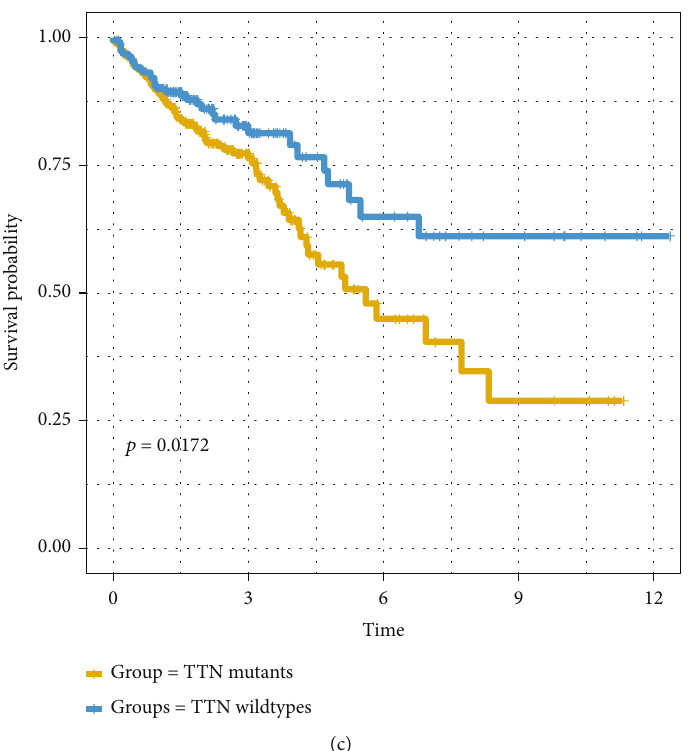
Figure 1: Correlation between TTN mutations and patient prognosis: (a) somatic mutation landscape of CRC patients; (b) correlation between patient prognosis and somatic mutations; (c) TTN mutations correlated with poor